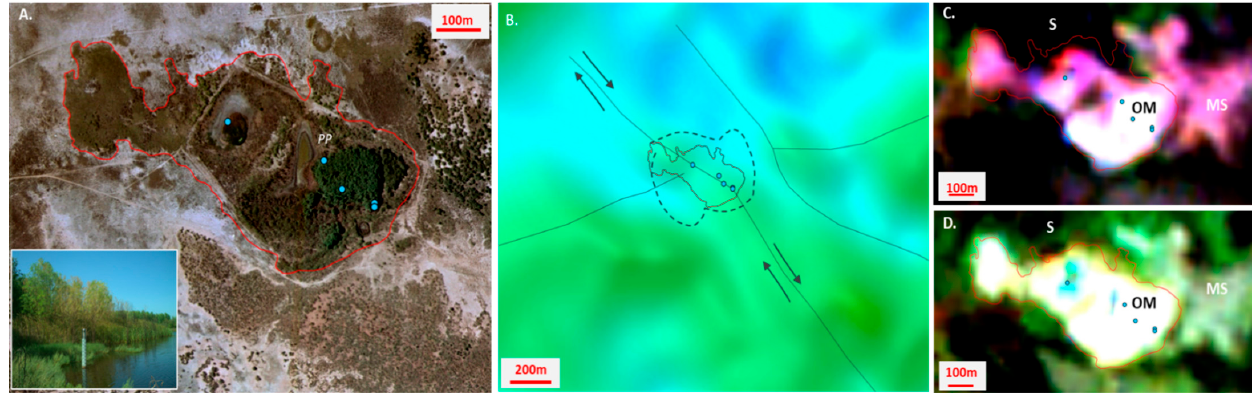
Figure 9. Structural interpretation of the Saunders spring complex: ( A ) Aerial photo (2010) interpretation of the Saunders spring complex boundary (red linework). Spring sampling locations are in blue; the inset photo is from a Reconyx camera installed near photo point PP to photograph the spring moat depth gauge. ( B ) AEM 2D inversion CDI image for depth interval 60–70 m BGL; spring complex extent in red; geological structures from Figure 6 are shown as solid black lines (arrows showing the direction of movement), with dashed black lines representing fault breakdown regions of concentrated stress (adapted from [80]). ( C ) Fractional cover model for years 1990, 1991 and 1992 and ( D ) fractional cover model for years 2014, 2015 and 2016. Abbreviations: OM (organic mound); MS ( Melaleuca shrublands); S (samphire shrublands).